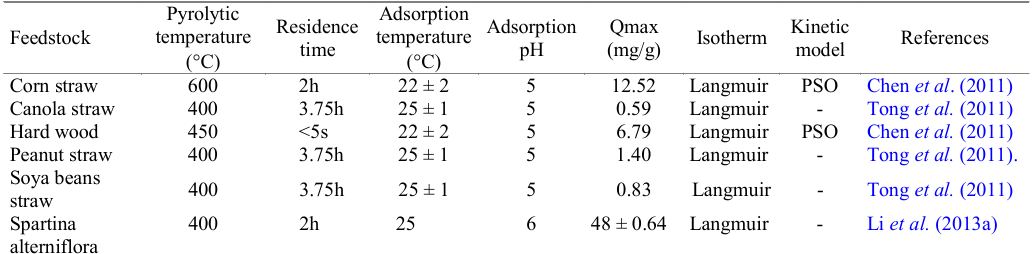
Table 6: Summary of agricultural adsorbent and their capacity (As discussed by Tan et al., (2015)